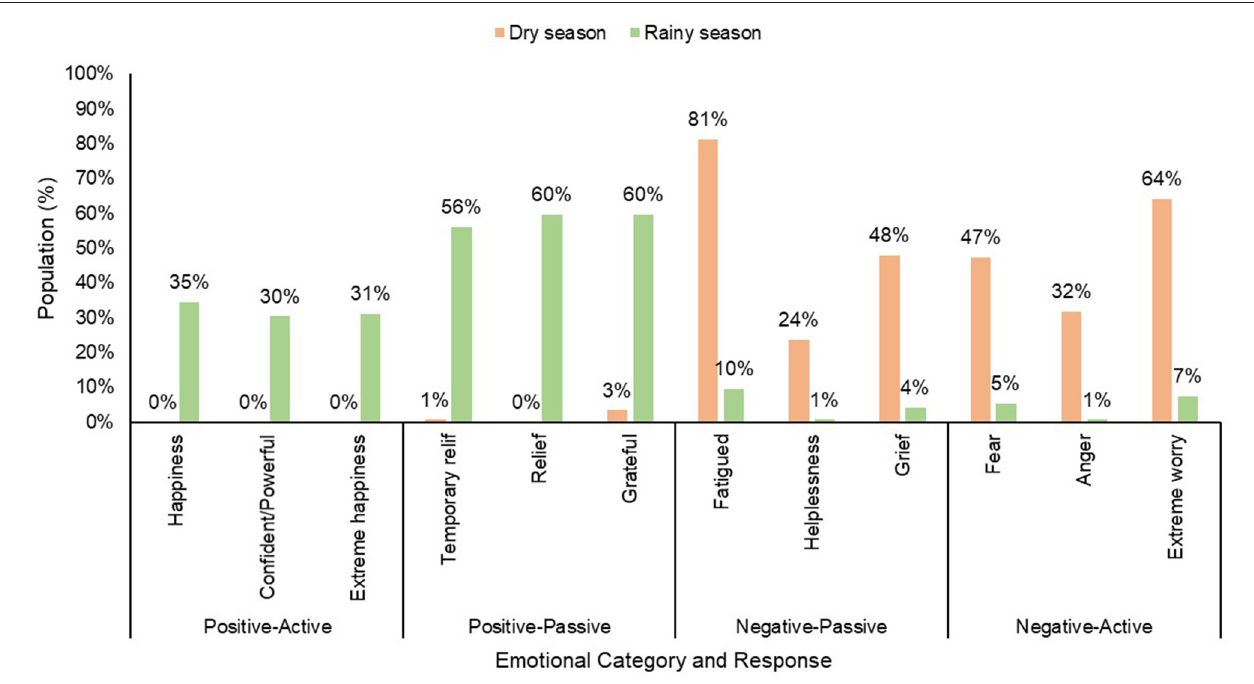
FIGURE 3 | Emotions experienced (%) by pastoralists in response to distance travelled to collect water by season in the Afar Region,